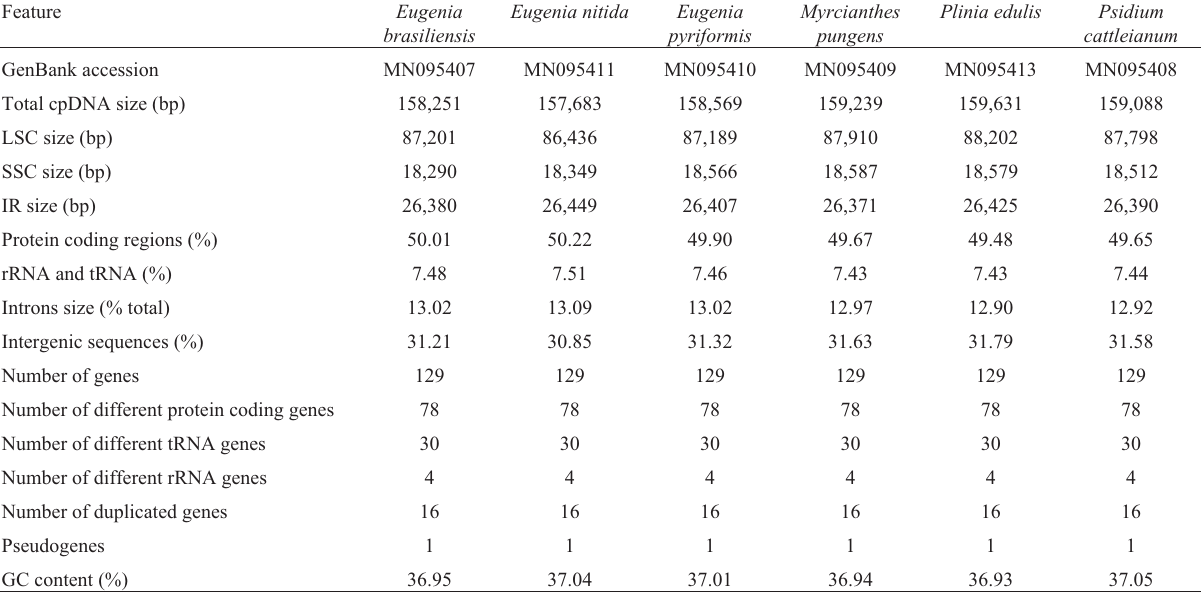
Table 1 - Myrteae chloroplast genome features.